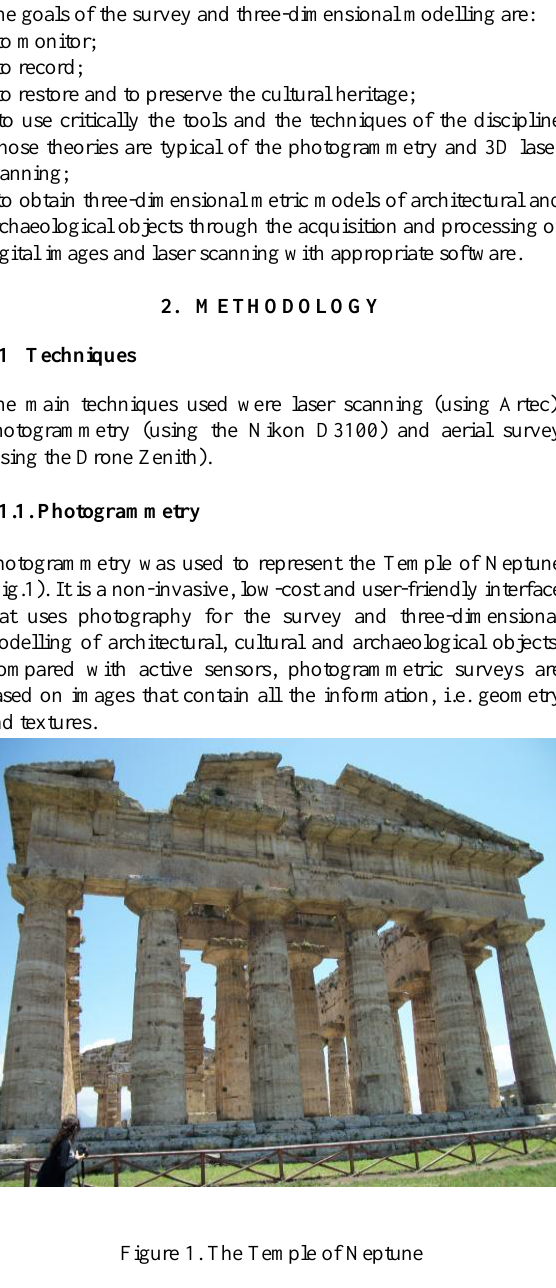
Figure 1. The Temple of